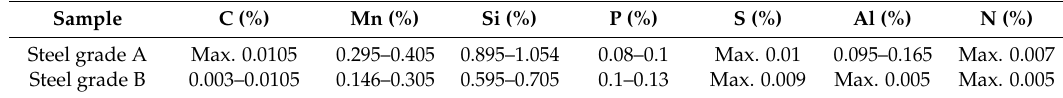
Table 2. Basic chemical composition of steel grades A and B.